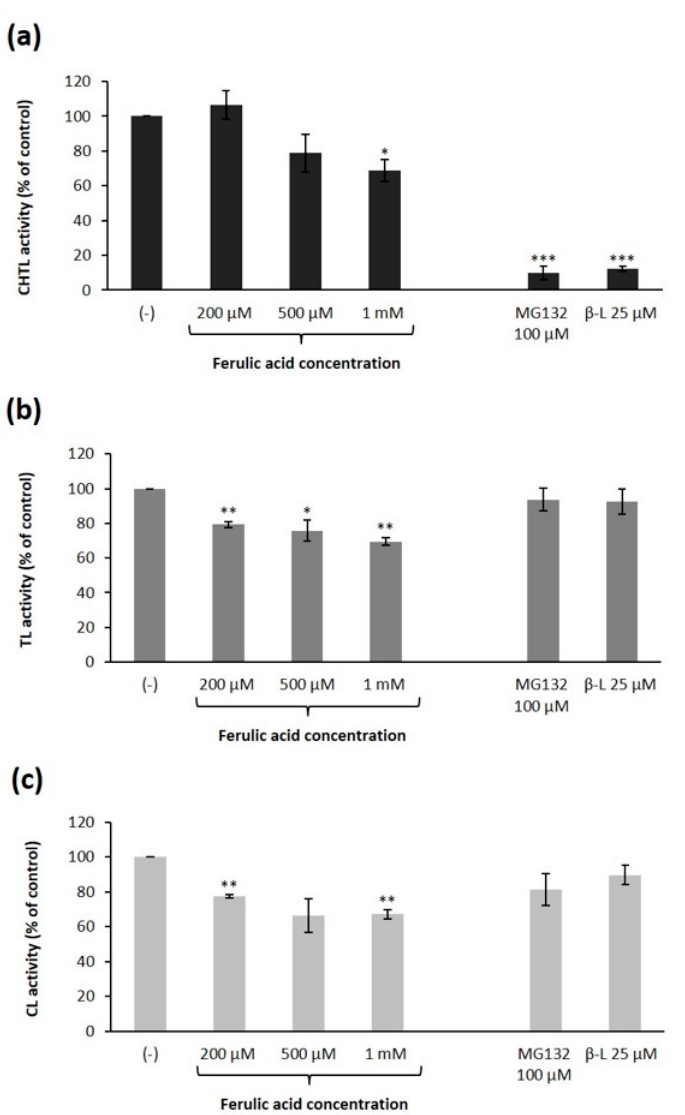
Figure 3. Effect of ferulic acid on peptidase activities of the 26S human proteasomes: ( a ) chymotrypsin-like (CHTL), ( b ) trypsin-like (TL), and ( c ) caspase-like (CL) activity. Reaction mixtures containing the 26S human proteasome solution were preincubated with ferulic acid at the indicated concentrations for 30 min before the addition of the fluorogenic peptide substrates: Suc-LLVY-AMC, Z-GGR-AMC and Z-LLE-AMC for measuring CHTL, TL, and CL activity, respectively. Proteasome inhibitors clasto-lactacystin β -lactone ( β -L) and MG132 were used as comparison to ferulic acid. The specific activity (nanomoles of AMC per mg of protein) of samples with the DMSO solvent alone was taken to be 100%. The data represent means ± SD of three independent experiments performed in duplicate (* p < 0.05, ** p < 0.01, and *** p < 0.001).